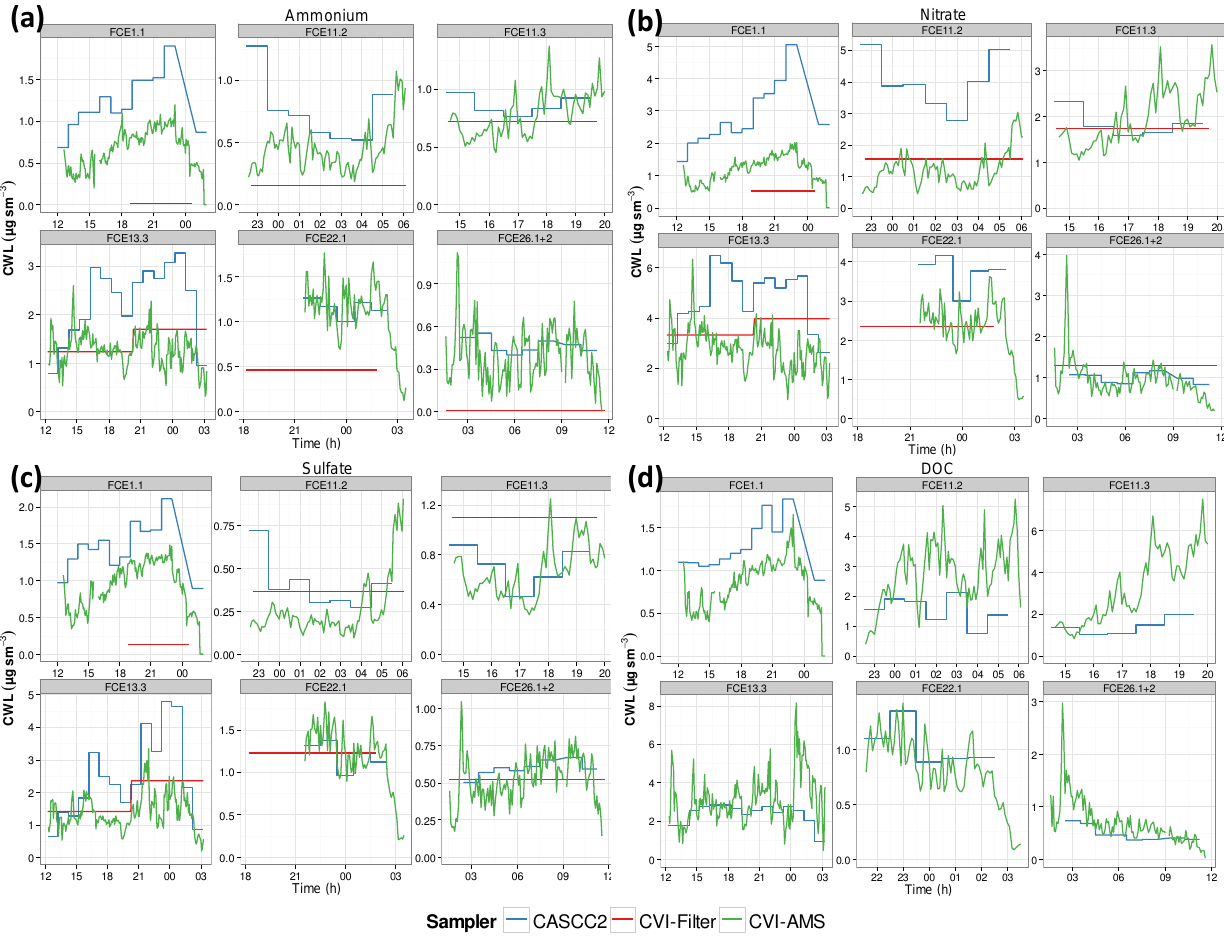
Figure 5. Comparison of cloud water loadings (normalised to standard temperature and pressure) from bulk cloud water collector (blue), quartz filter downstream CVI inlet (red), and AMS downstream CVI (green) for cloud water main constituents (a) ammonium, (b) nitrate, (c) sulfate, and (d) DOC (AMS